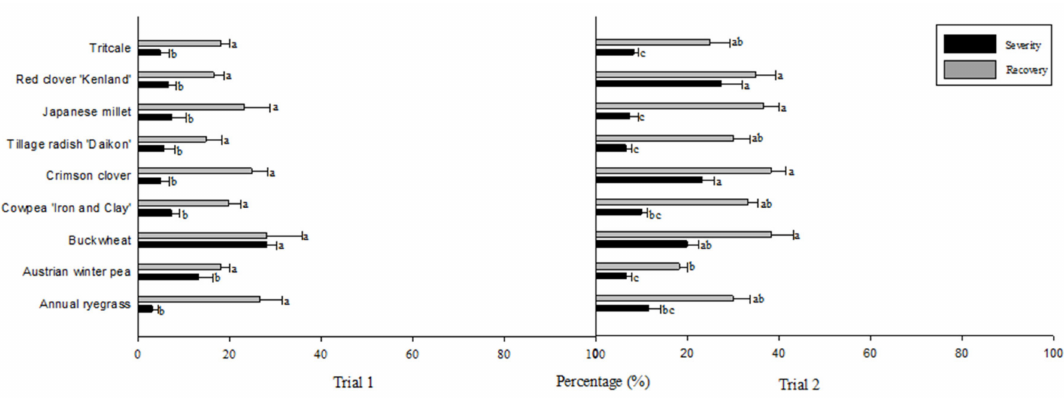
Figure 1. Disease severity and recovery (mean ± SE) of cover crop roots when Phytophthora nicotianae was inoculated in the soil. Phytophthora root rot disease severity was evaluated using a scale of 0–100% of roots affected. For each replication, ten randomly selected cover crop root samples were plated V8-PARPH oomycete-selective medium to determine the percent recovery of P. nicotianae from root samples. Different letters on the bars indicate significant differences in Phytophthora root rot disease severity or pathogen recovery among cover crops (Trial 1: Severity: F = 12.57, p < 0.0001; Recovery: F = 1.31, p = 0.2633; Trial 2: Severity: F = 12.29, p < 0.0001; Recovery: F = 3.51, p = 0.0031; df MST,MSE = 8, 45; α = 0.05, least square means).